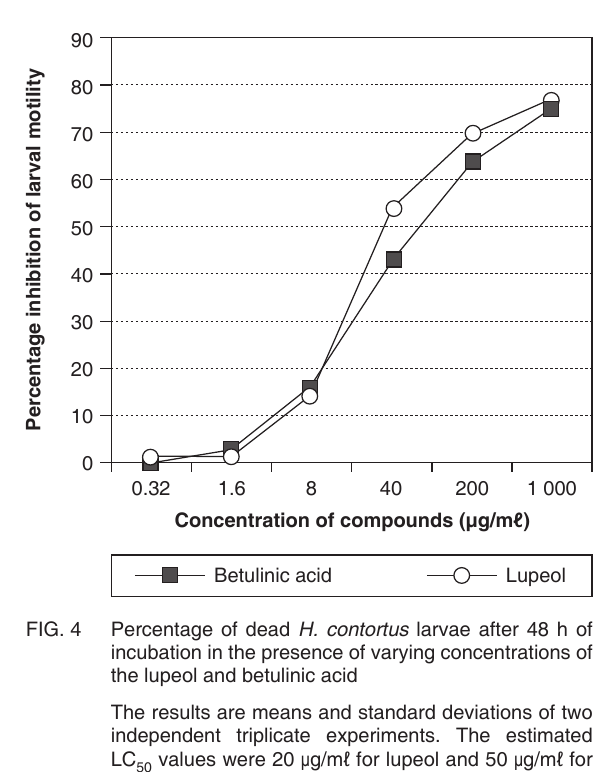
FIG. 3 Percentage of dead T. colubriformis larvae after 48 h of incubation in the presence of varying concentrations of the lupeol and betulinic acid The results are means and standard deviations of two independent triplicate experiments. The estimated LC value was 80 μ g/m ℓ for both lupeol and betulinic 50